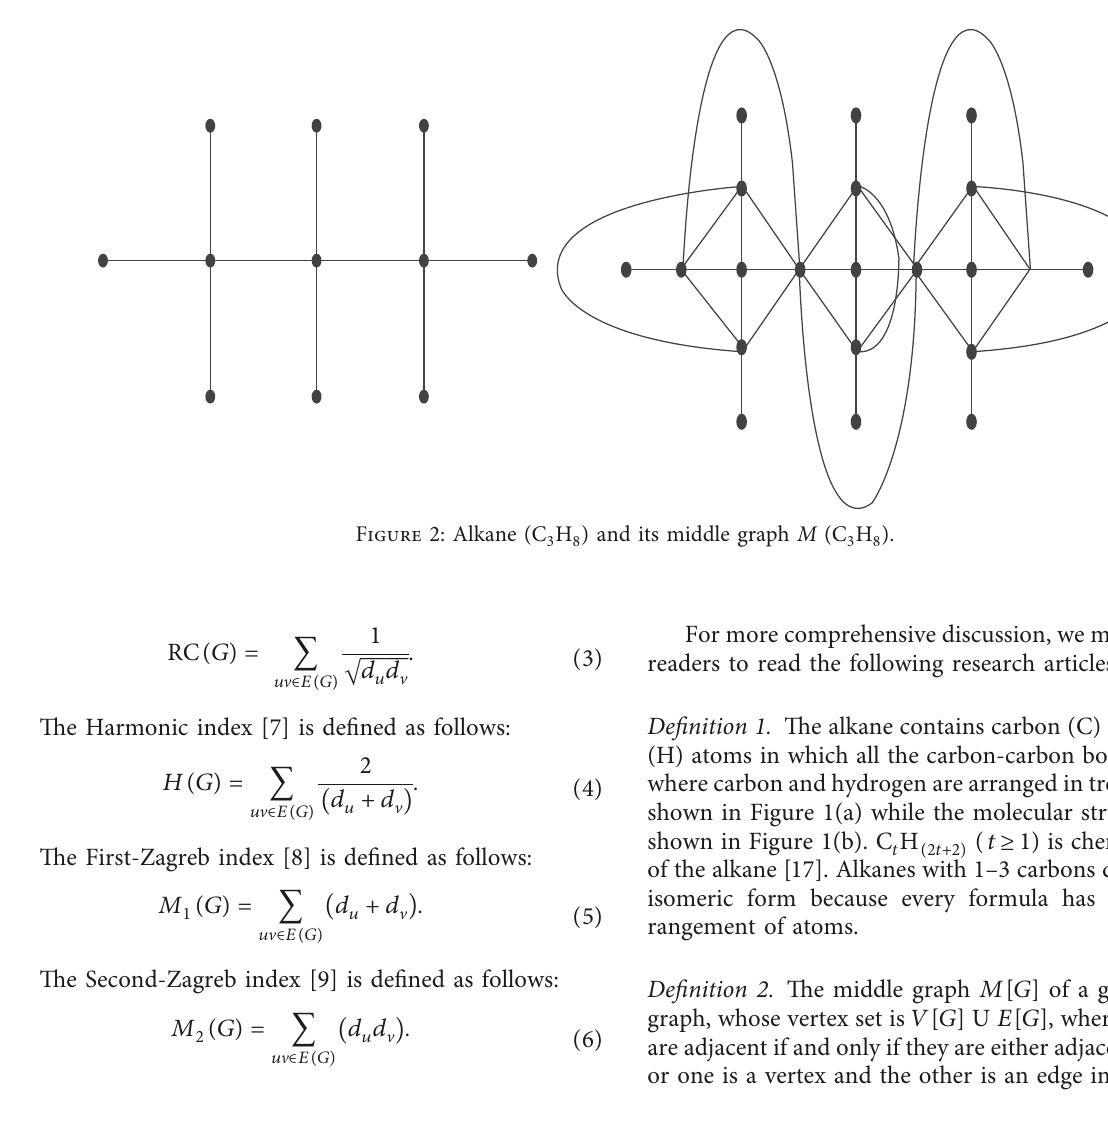
4 , C 2 H 6, and C 3 H 8 ).